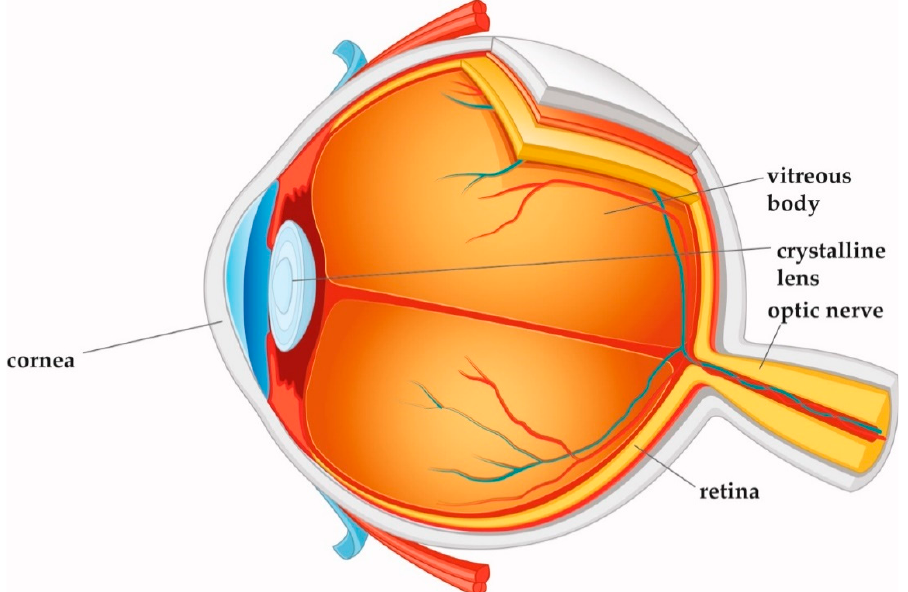
Figure 1. Cross-section of the eye. Cornea, crystalline lens, and vitreous body are transparent in the healthy eye.